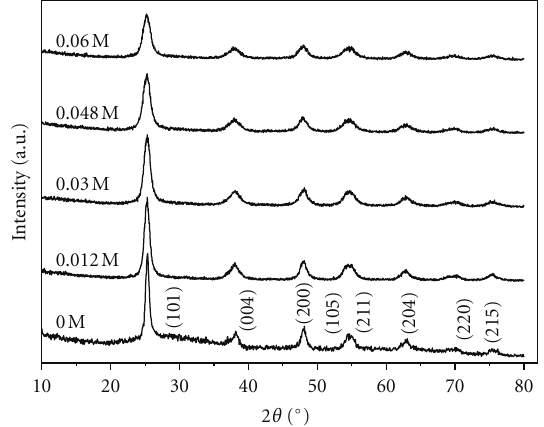
Figure 1: XRD patterns of mesoporous TiO 2 -Al 2 O 3 binary